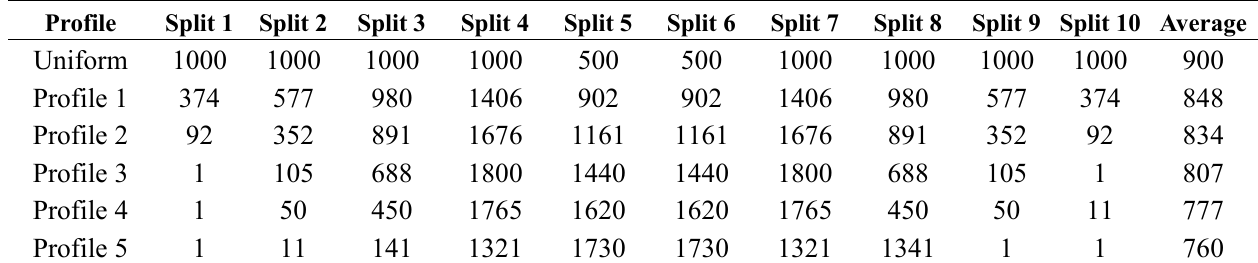
Table 6. Irradiance values for ten cell splits in the array modelling (W/m 2 ).